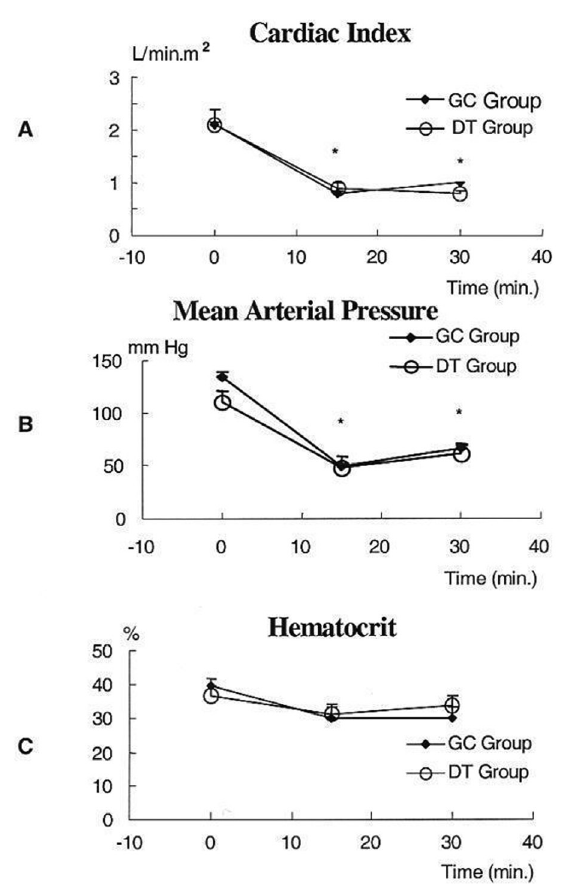
Figure 2 – Cardiac index (Panel A), Mean Arterial Pressure (Panel B), and Hematocrit (Panel C) were measured before (time = 0 min) and after (time = 15 min and 30 min) the creation of bilateral iliac artery injuries. No dif- ferences were observed in these parameters between the GC and DT groups. Retroperitoneal hematoma formation led to a significant decrease in cardiac index and mean arterial pressure at 15 min and 30 min